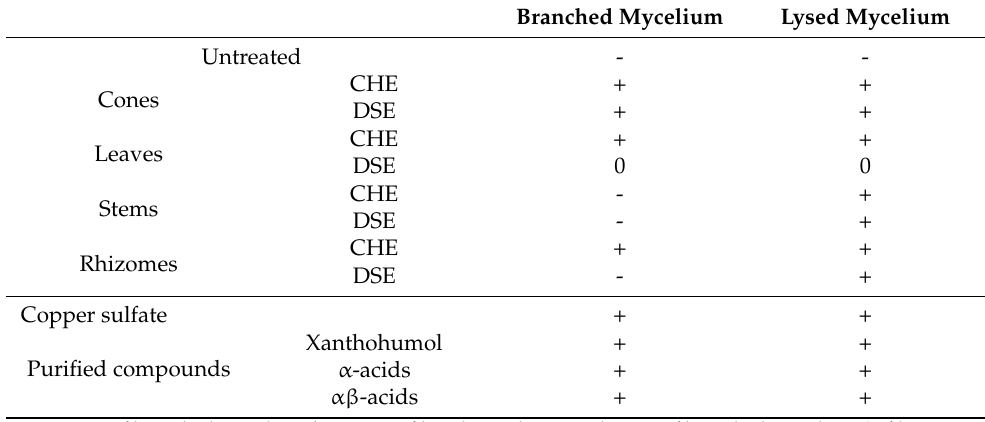
Table 5. Optical observations of P. infestans mycelium morphology under different hop part extracts, metabolites, and copper sulfate